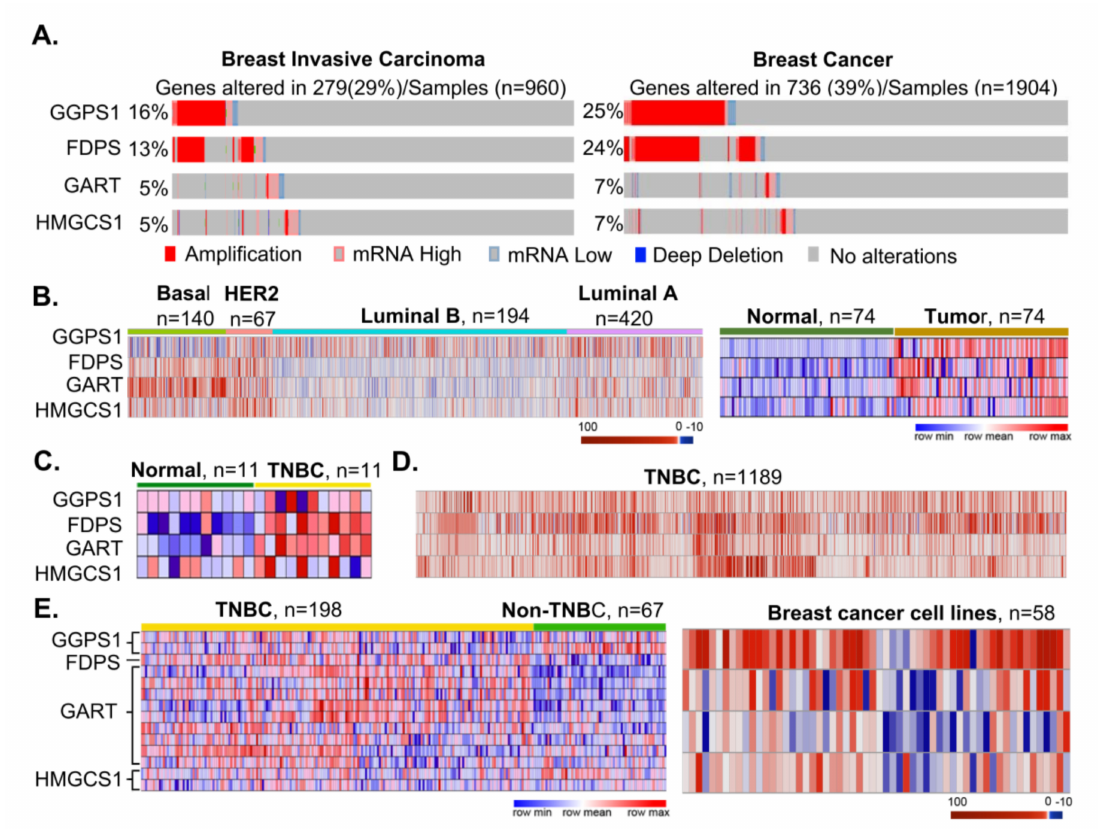
Figure 4. Expression of GGPS1, FDPS, HMGCS1 and GART in breast cancer. ( A ) Amplification and expression of indicated molecules in breast tumors in The Cancer Genome Atlas (TCGA) (left) and Metaberic data (right) [49] using Copy Number Variation (CNV) and gene alteration rate data from cBioPortal.org [29,30]. ( B ) Expression of GGPS1, FDPS, GART and 3-Hydroxy-3-Methylglutaryl-CoA Synthase 1 (HMGCS1) mRNAs in breast cancer sub-types, in breast tumors and adjacent matched normal tissues using the data from cBioPortal (left panel) [29,30] and from Xena Browser (right panel) [31]. ( C—E ) Expression of indicated four mRNAs in TNBC and matched normal tissues from Xena Browser (right panel) [31], in TNBC samples [50], in TNBC and non-TNBC breast tumors, and breast cancer cell lines [51]; Right panel: Gene expression representation using heatmap in breast cancer cell lines—AU565, BT20, BT474, BT483, BT549, CAL120, CAL148,